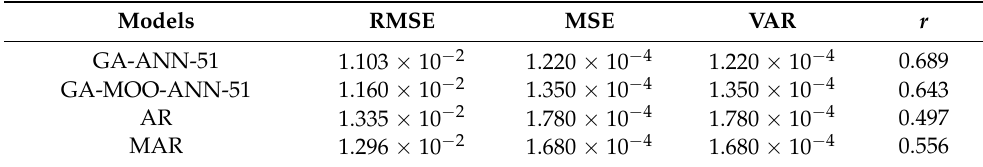
Table 8. The comparison of best performances of various types of forecasting models based on MAE, r , VAR, and RMSE.